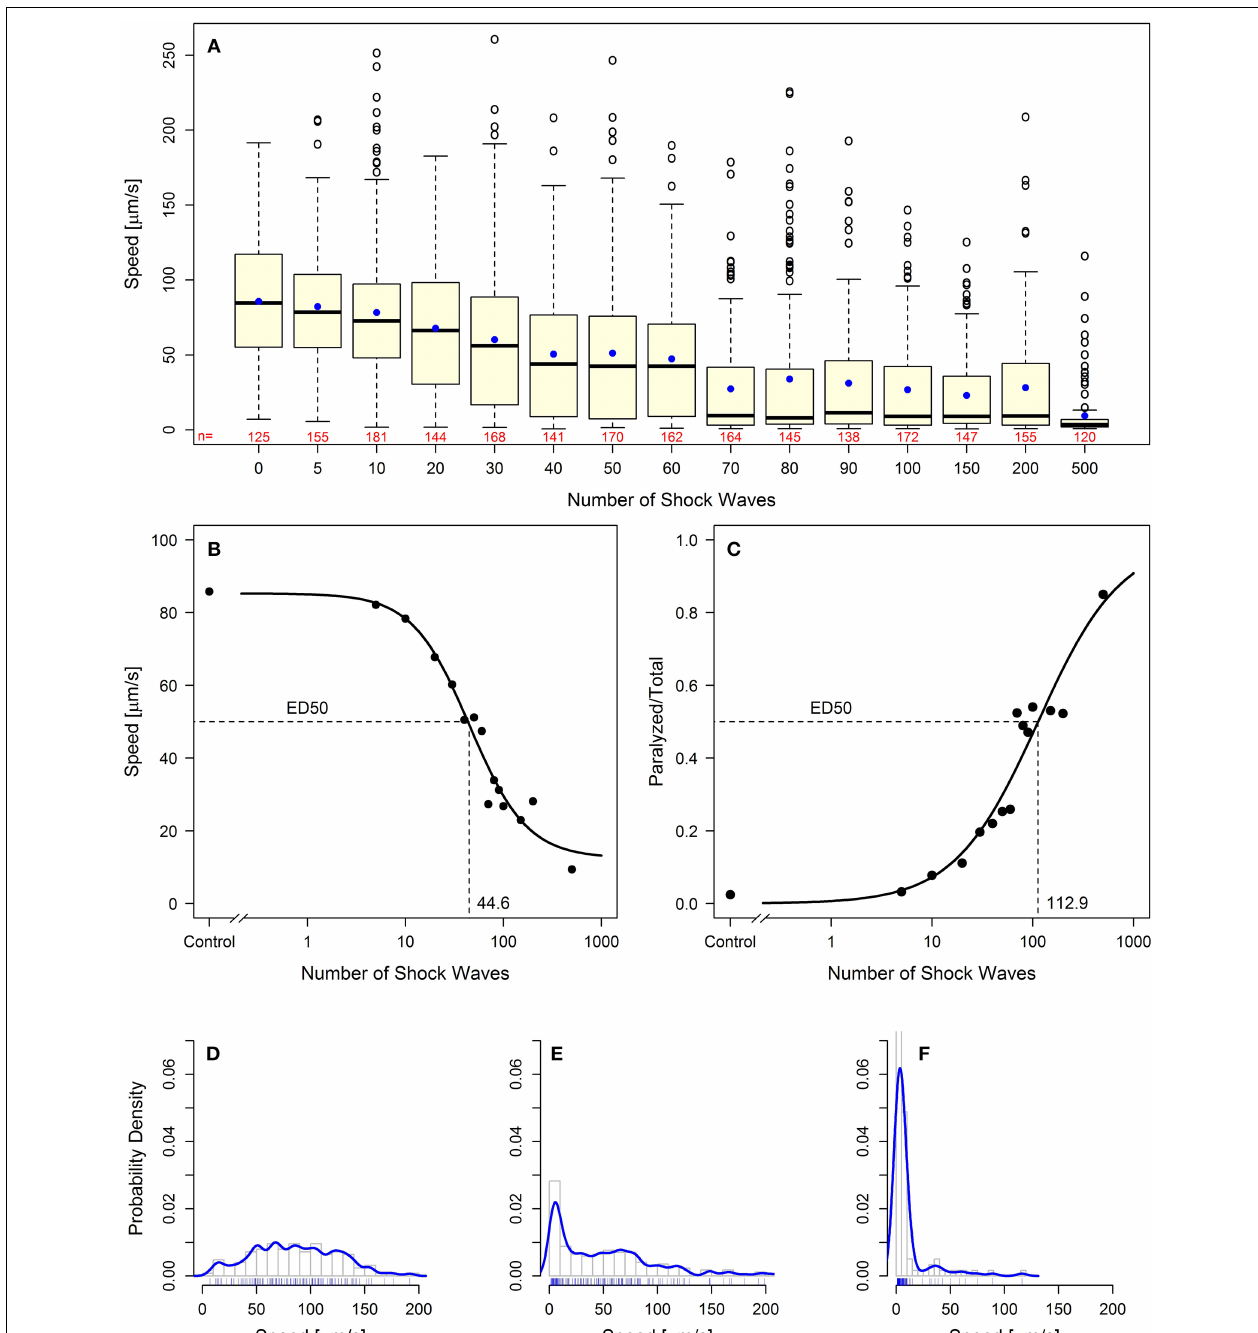
FIGURE 2 | Behavioral loss-of-function of C. elegans worms following shock wave exposure. (A) Increased exposure to shock waves resulted in decreased mean speed of movement in all groups of worms exposed to at least 30 shock waves ( p < 0 . 05). Represented as individual points, 97 positive-lying outliers were found within shock wave exposed groups of worms. Horizontal lines within the boxes represent median speeds, dots within the boxes average speeds, and box and whiskers were plotted using the Tukey method. The numbers below the boxes indicate the numbers of worms per group. (B) Worms exhibited dose-dependent response to shock wave application (ED 50 = 44 . 6 shock waves) using the